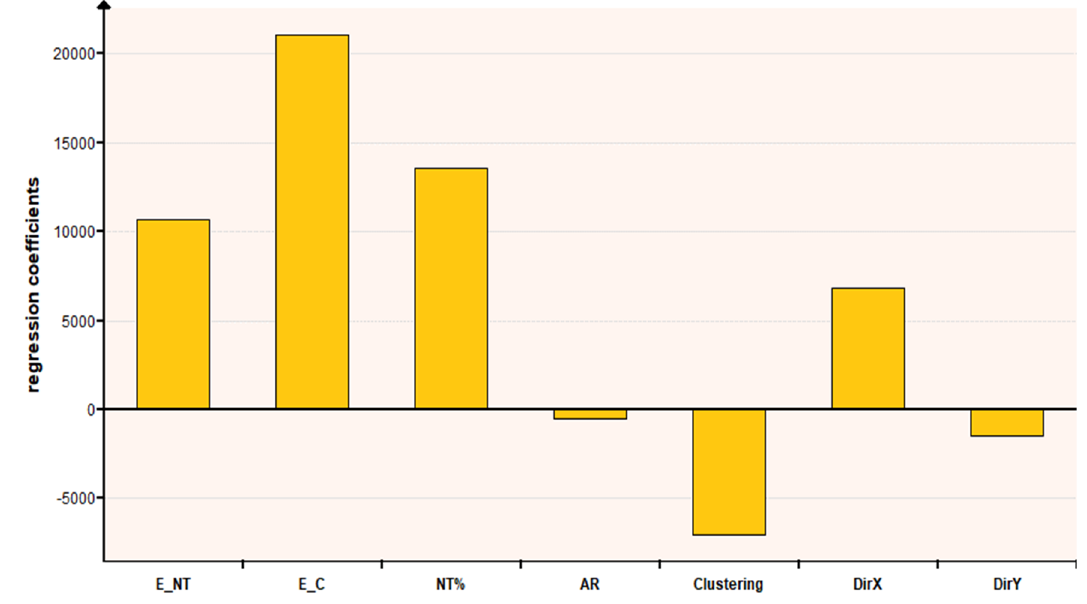
Figure 8. Regression coefficient of each parameter.